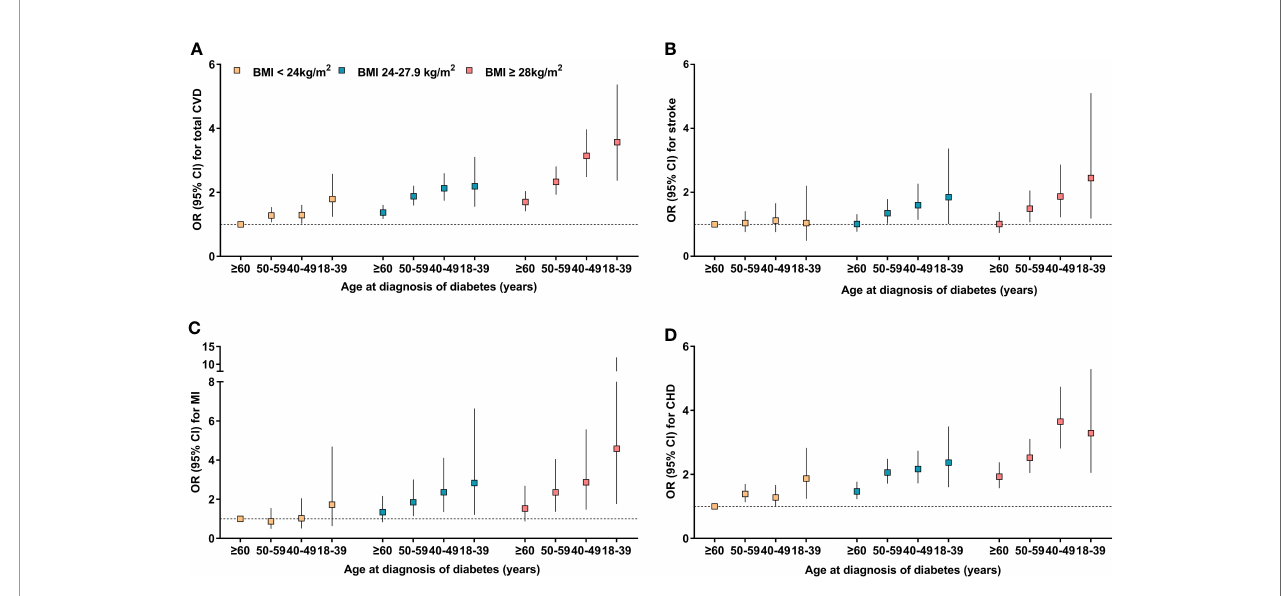
FIGURE 1 | Adjusted odds ratios for cardiovascular disease risk according to combinations of BMI and age at diagnosis of diabetes. (A) cardiovascular disease; (B) Stroke; (C) Myocardial infarction; (D) Coronary heart disease. ORs (95% CIs) were adjusted for age, sex, education, smoking status, drinking status, physical activity, healthy dietary, systolic blood pressure, total cholesterol, triglycerides and